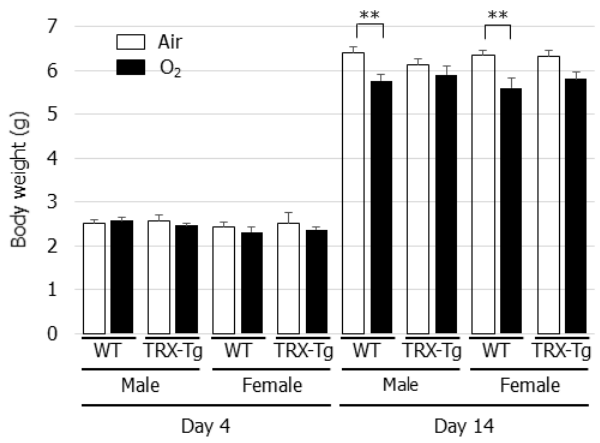
Figure 1. Changes in body weight after neonatal hyperoxic exposure. The changes in body weight were evaluated in 4 and 14-day-old WT and TRX-Tg mice following normoxic or hyperoxic exposure ( n = 6 per group). Data are shown as means ± SEM. Comparisons between groups were performed using one-way ANOVA followed by Tukey’s test. ** p < 0.01. WT: wildtype; TRX: Thioredoxin-1; Tg: